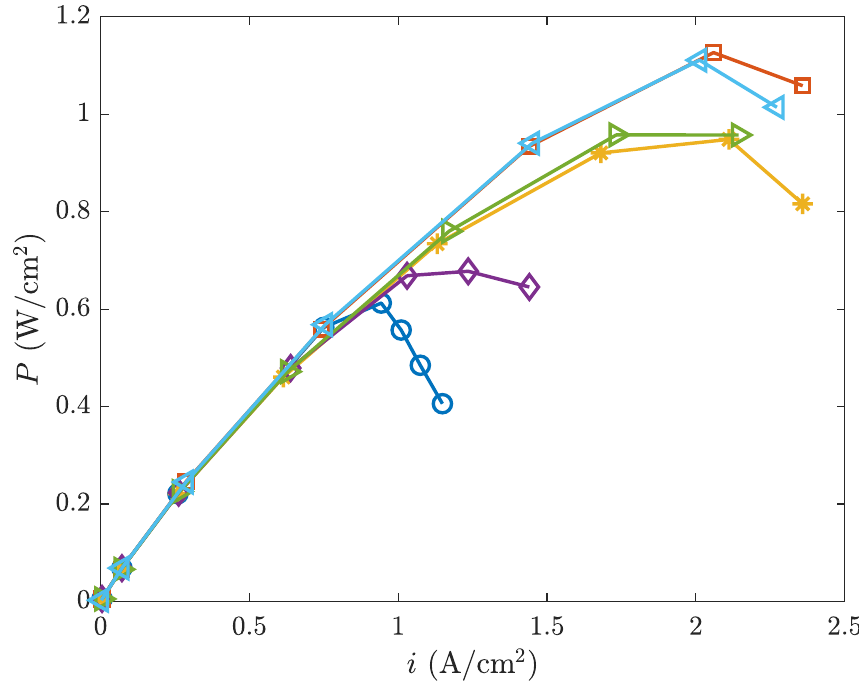
Figure 4. Comparison power vs. current density for all the studied cases. Same legend as in Figure